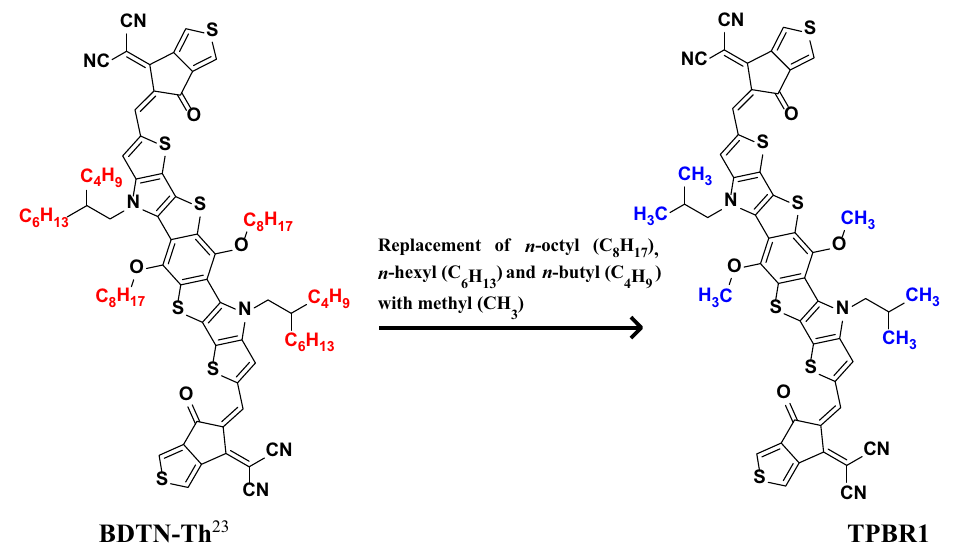
Figure 1. Side-chain modification of parent molecule ( BDTN-Th ) 23 into a reference ( TPBR1 ) molecule. These structures are drawn with the help of ChemDraw software (https:// chemi stryd ocs. com/ chemd raw- pro-8-